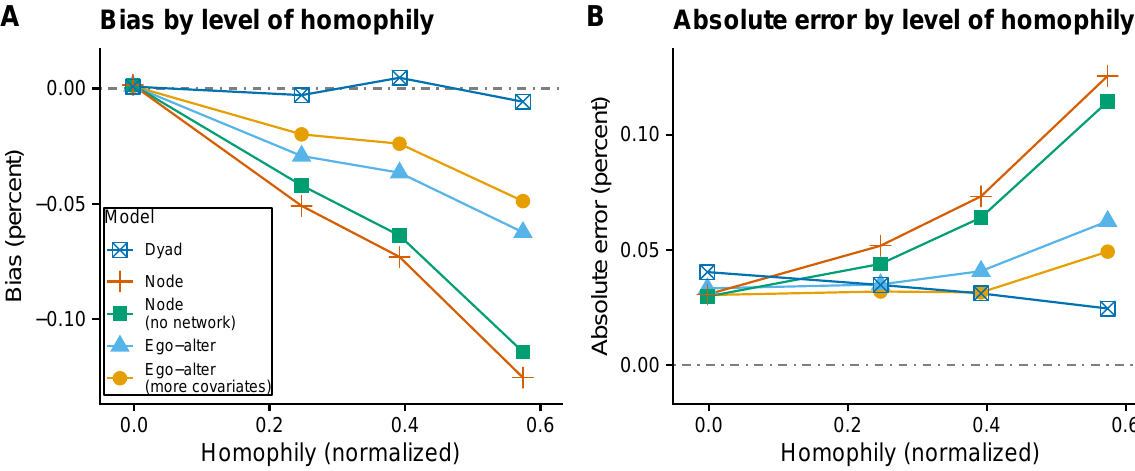
Figure 5: As homophily increases (increasing β in Eq. [8]), bias and absolute error increase for all non–edge- level models. At high homophily values, the edge model becomes the lowest overall error approach while maintaining unbiasedness. This plot displays results for edge sampling, but results are similar for node and proportional-to-degree